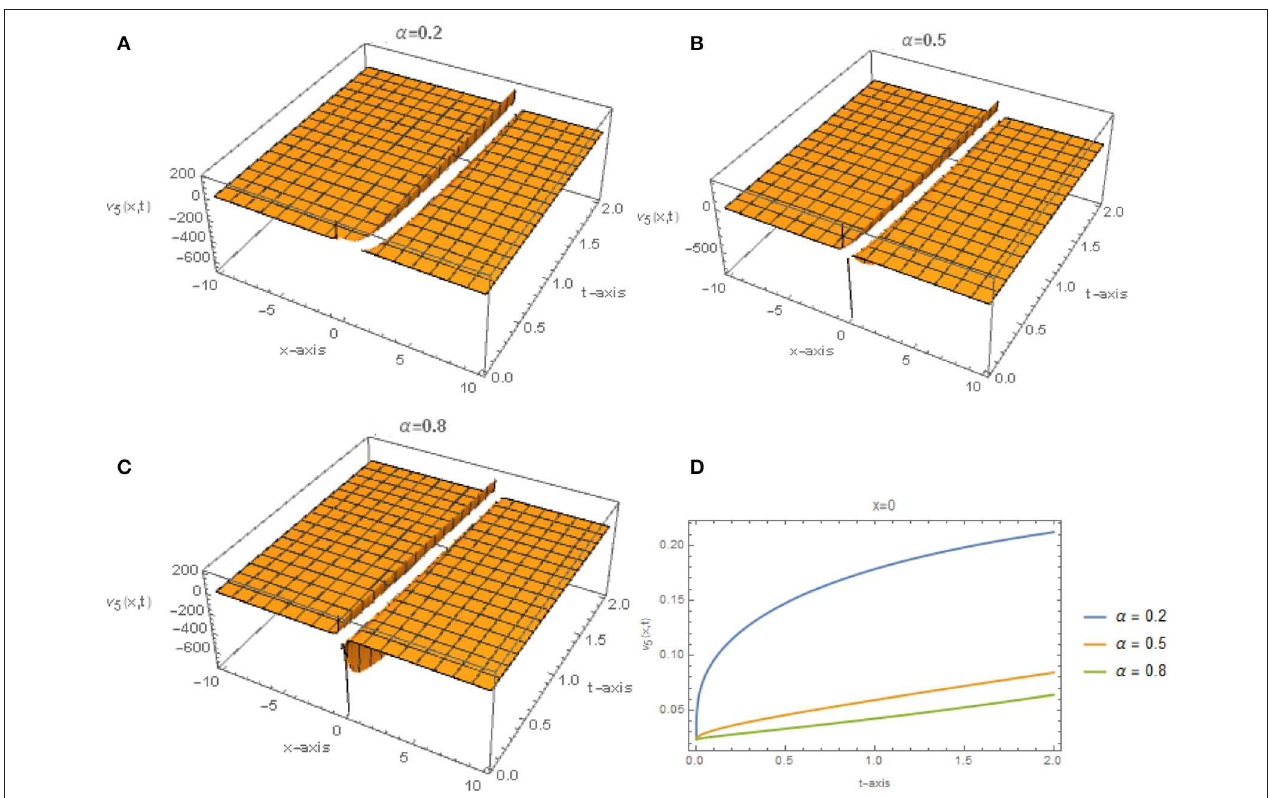
FIGURE 6 | (A–D) The Solution v_5 (x,t) given by Eq.